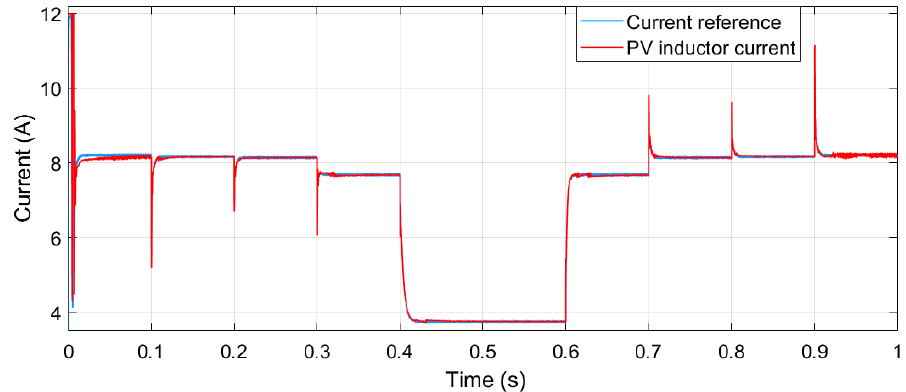
Figure 10. PV voltage.